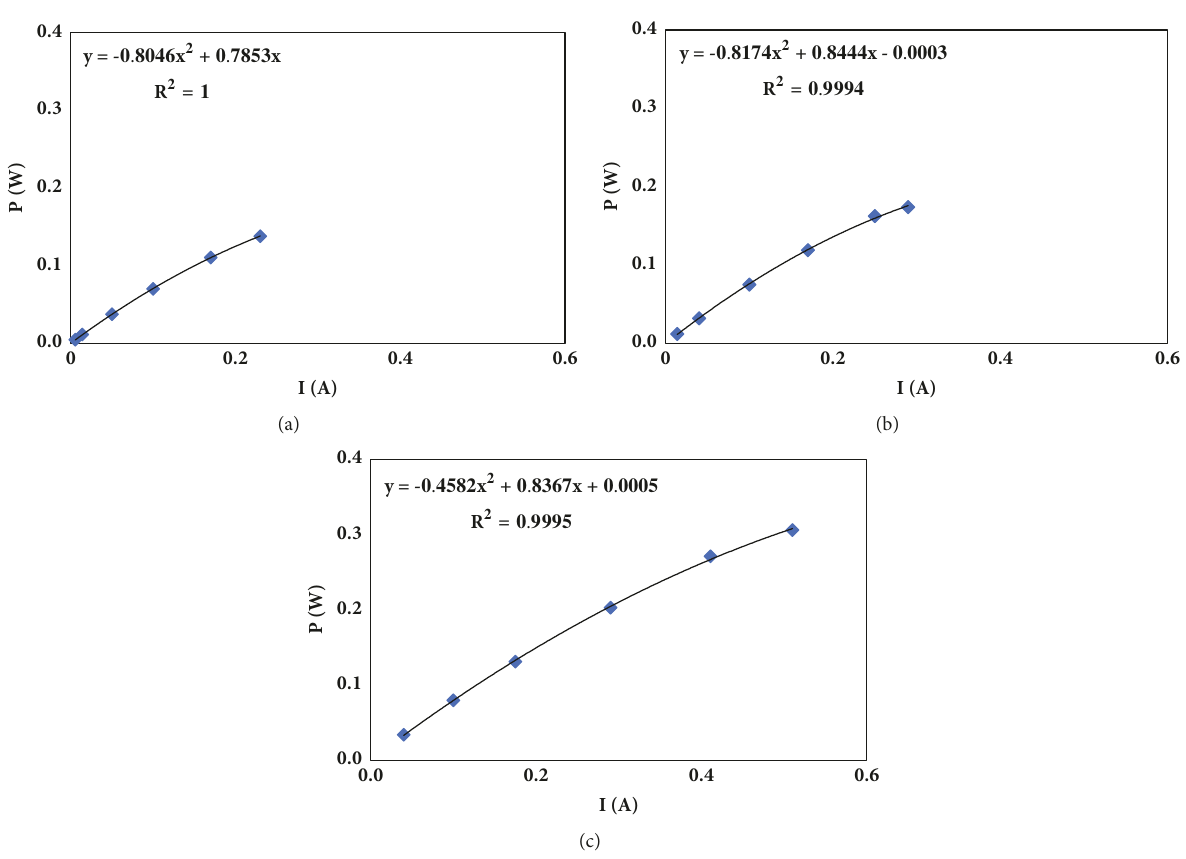
Figure 7: Graphical representation of power as a function of current intensity for three different cathodes of a PAFC (a) 10 wt % Pt/C, (b) 20 wt % Pt/C, and (c) 20 wt % Pt-alloy